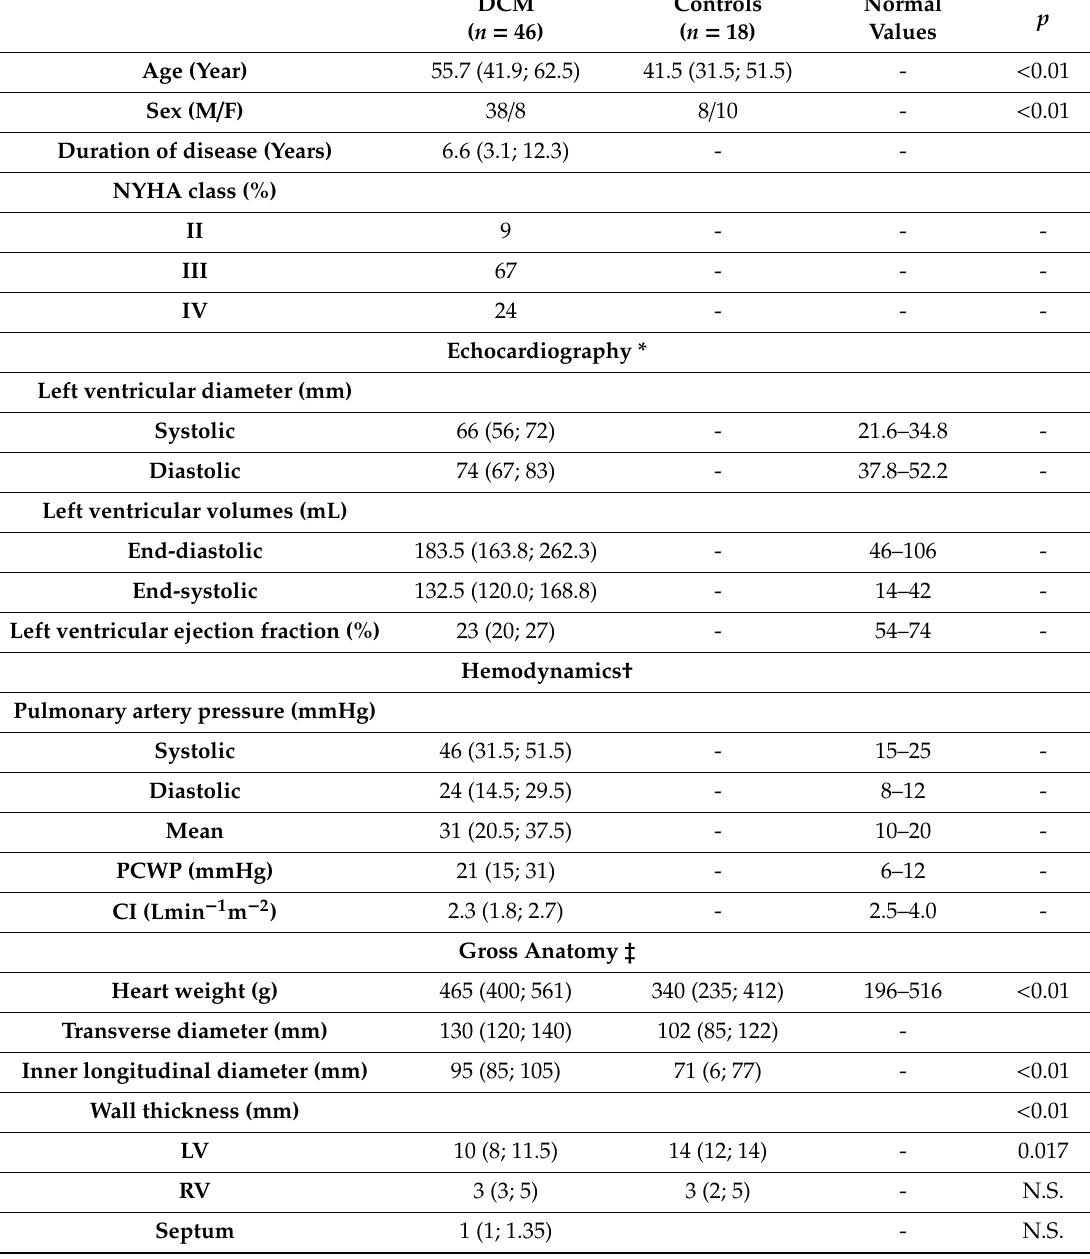
Table 8. Demographic, echocardiographic, and anatomical features of patients whose hearts were analyzed histologically.